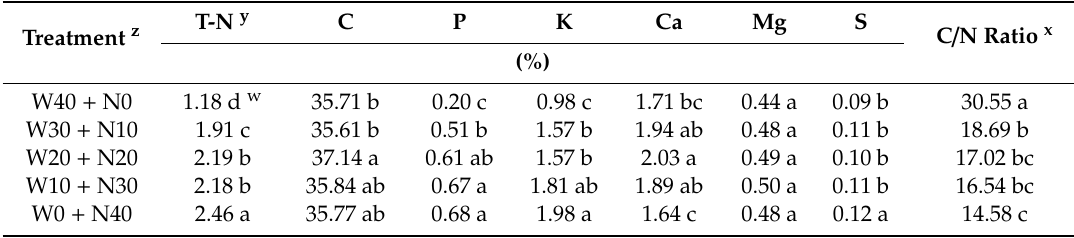
Table 2. Concentration of macroelements in the shoots of “Maehyang” strawberry runner plants a ff ected by the nutrient solution resupply period during the nursery stage ( n = 6). Treatment